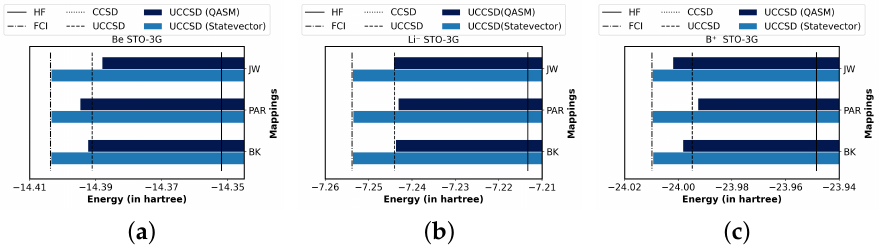
Figure 3. Graphical illustration of results for the ( a ) Be, ( b ) Li − , and ( c ) B + in STO-3G basis obtained using the variational quantum eigensolver algorithm. The figure serves to compare the impact of different combinations of fermion to qubit mapping techniques, namely Jordan–Wigner (JW), parity (PAR), and Bravyi–Kitaev (BK) transformations, as well as backend simulators (statevector and QASM). The dark blue bars indicate the energies obtained on a QASM simulator, while the bars in light blue specify the energies computed using a statevector simulator. The calculated energies are compared with full configuration interaction (FCI) (dot-dash line), and also with CCSD (dotted line), and UCCSD (dashed line) methods. Each of the plots also show the Hartree-Fock (HF) energy as a black solid line, which allows to visualize the correlation